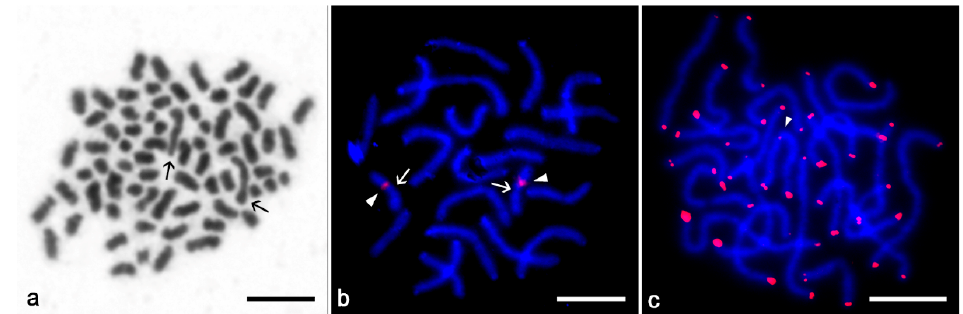
Figure 4. Chromosomes of Sarax after Giemsa staining ( a ) and mapping of repetitive DNAs by FISH ( b , c ). ( a , b ) Mitotic metaphases; ( c ) mitotic prometaphase. ( a ) S. ioanniticus , female. Chromosomes of the largest pair (arrows) differ by degree of condensation from the rest of the complement. ( b ) S. seychellarum , female. Chromosomal mapping of 18S rDNA clusters (red signals, arrowheads). Centromeres are marked by arrows. Chromosomes counterstained with DAPI (blue). ( c ) S. seychellarum , male. Chromosomal mapping of telomeric motif (TTAGG) n (red signals). Arrowhead points to the interstitial telomeric site. Chromosomes counterstained with DAPI (blue). Scale bar = 10 μ m. Animals 2021 , 11 , x